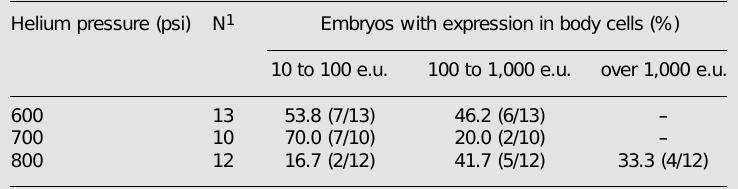
Table 4. Effect of helium pressure on number of expression units in body cells of embryos placed 0.5 cm from the center of the particle dispersion cone, using gold particles and 500 mmHg